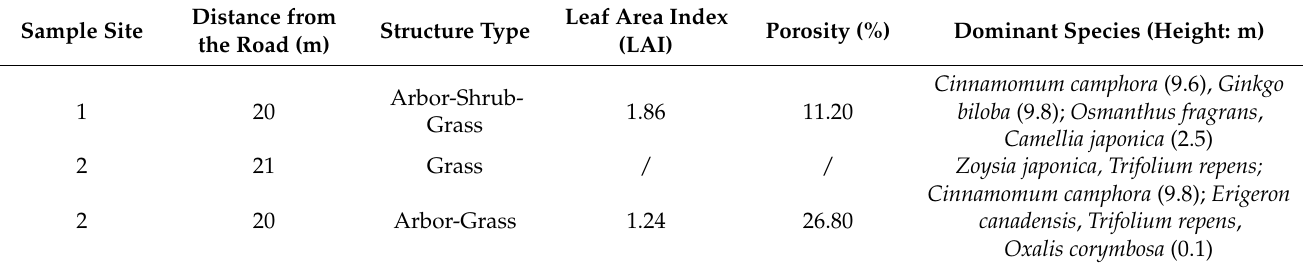
Figure 1. ( a ) The location of the sampling sites in Shanghai, China; ( b ) the locations of three sampling sites in the campus of Shanghai Jiao Tong University, Minhang district; the instrumentation locations of measuring stations beside the Danshui River in three vegetation types: ( c ) arbor-shrub-grass woodland (ASG), ( d ) open grassland (G) and ( e ) arbor-grass woodland (AG); the instrumentation locations and heights of measuring stations in three vegetation types: ( f ) arbor-shrub-grass woodland (ASG), ( g ) open grassland (G) and ( h ) arbor-grass woodland (AG). Table 1. Sample sites, distance from the road, greenbelt structure and arrangement of